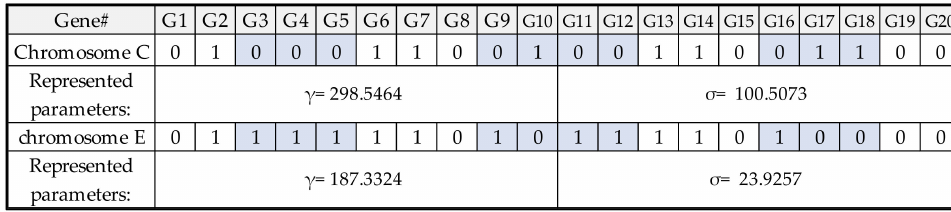
Figure 8. The binary encoding for parameters of LSSVR after mutation from chromosome C to